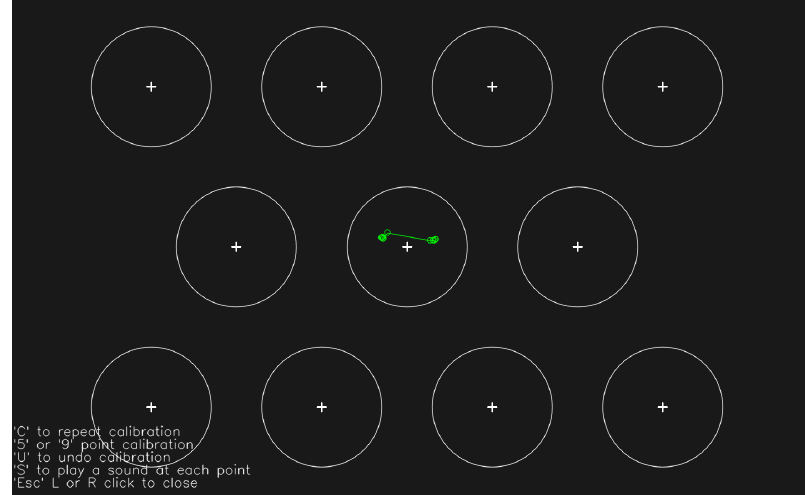
Figure 3. The Gazepoint Control software’s screen used to test the calibration results. The user is asked to look at the centre of each circle. The calibration is assumed to be successful if the gaze, represented in green, never lands outside the circle being attended by the